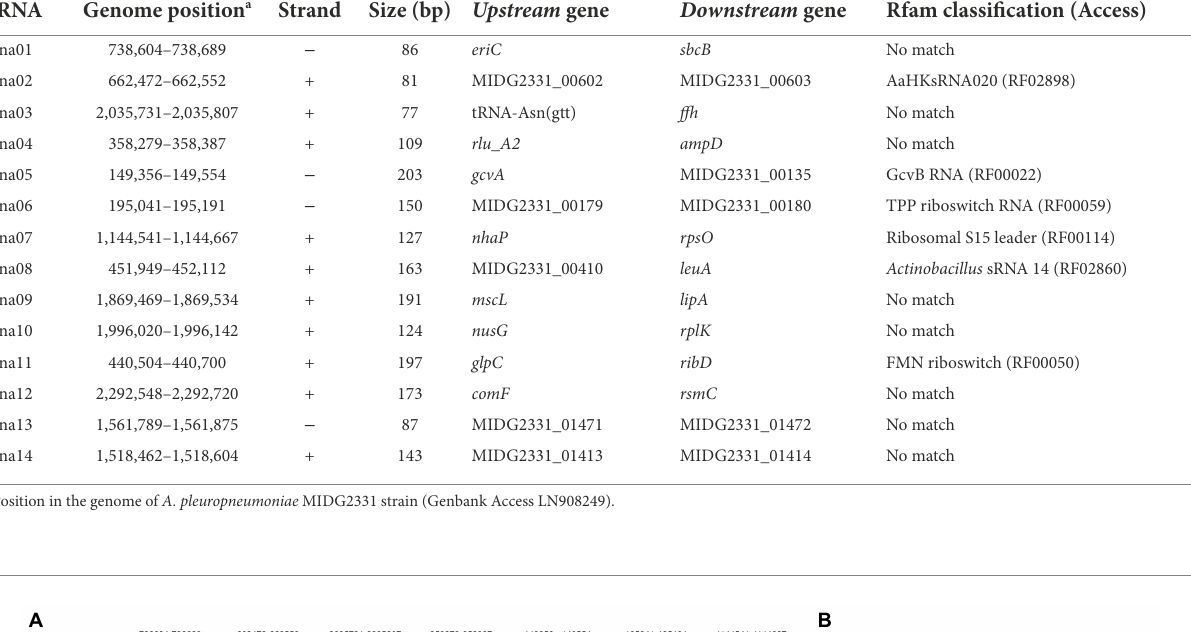
TABLE 3 Regulatory sRNAs identified in this work by Hfq Co-immunoprecipitation in Actinobacillus pleuropneumoniae.